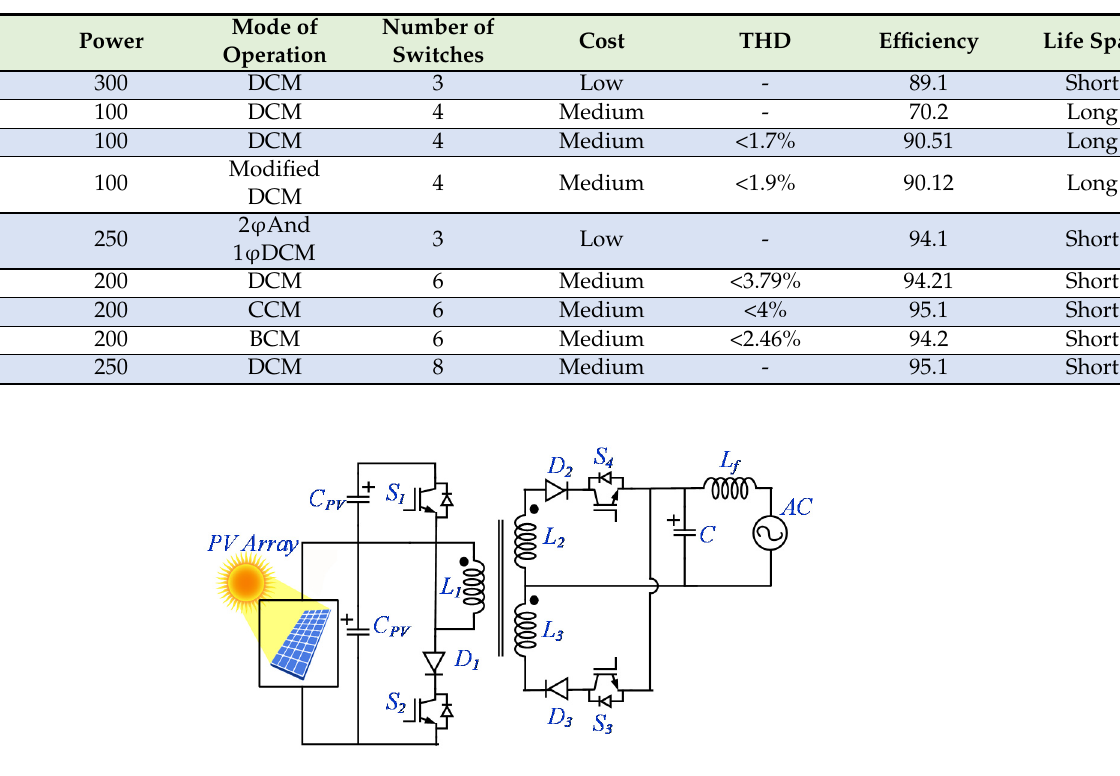
Figure 21. Single stage fly-back inverter with decoupling circuit .